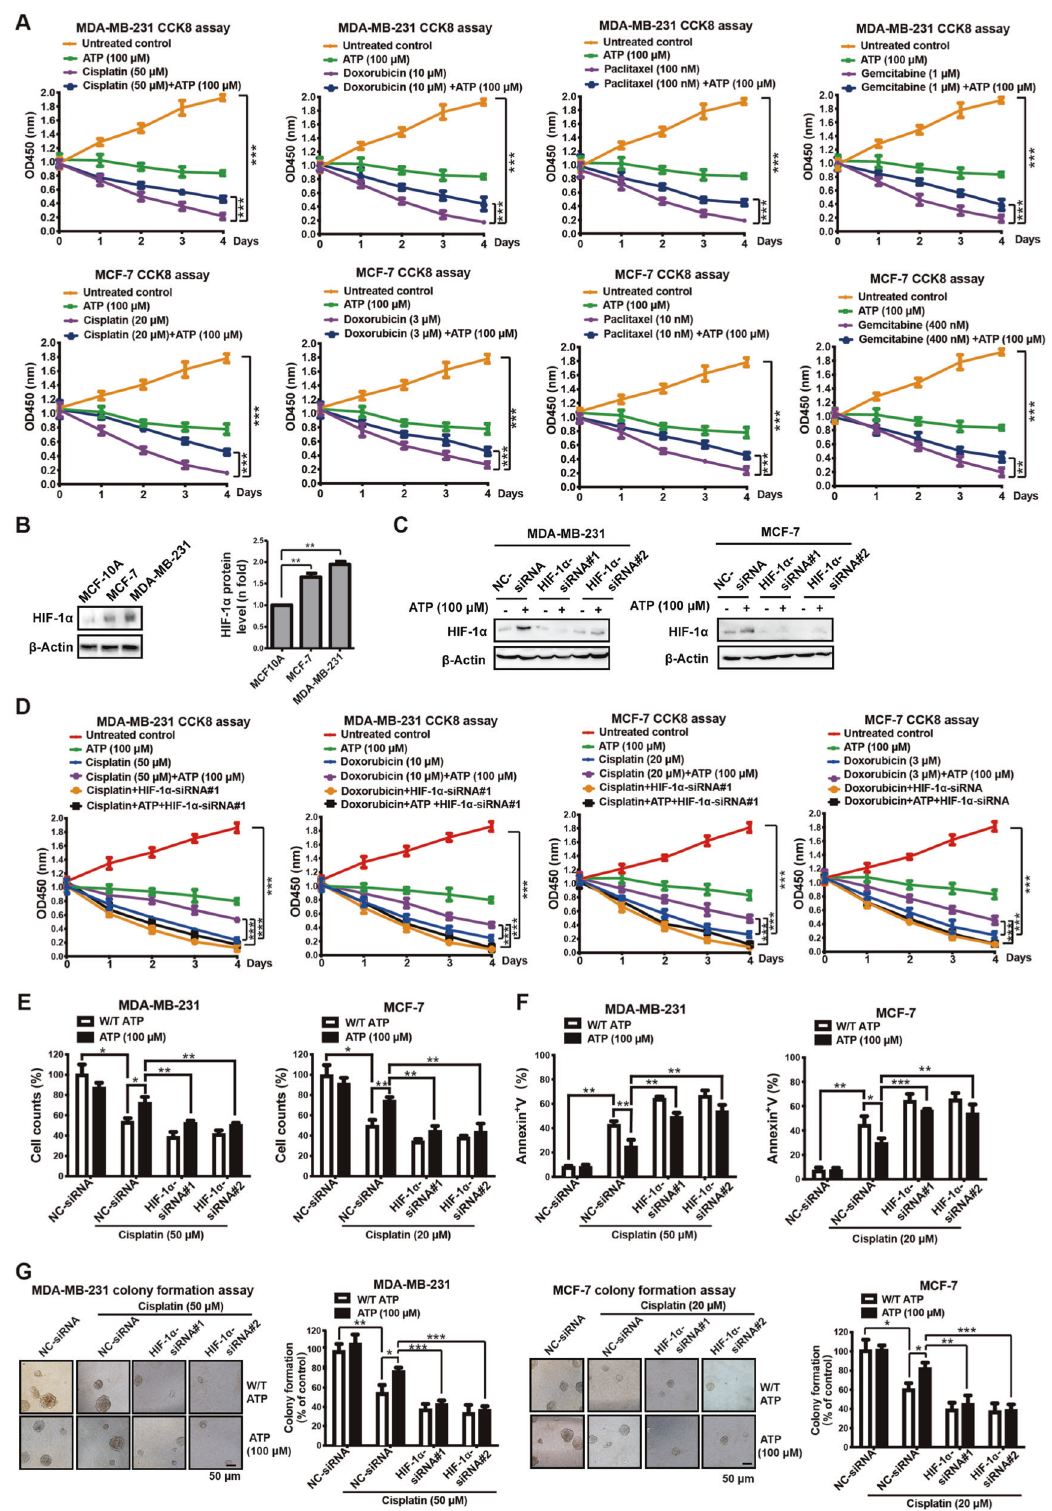
effectiveness of clinical cancer therapies. However, whether HIF-1 α is the sole critical factor that ATP affects to promote chemoresistance in breast cancer cells and the underlying mechanism involved remain